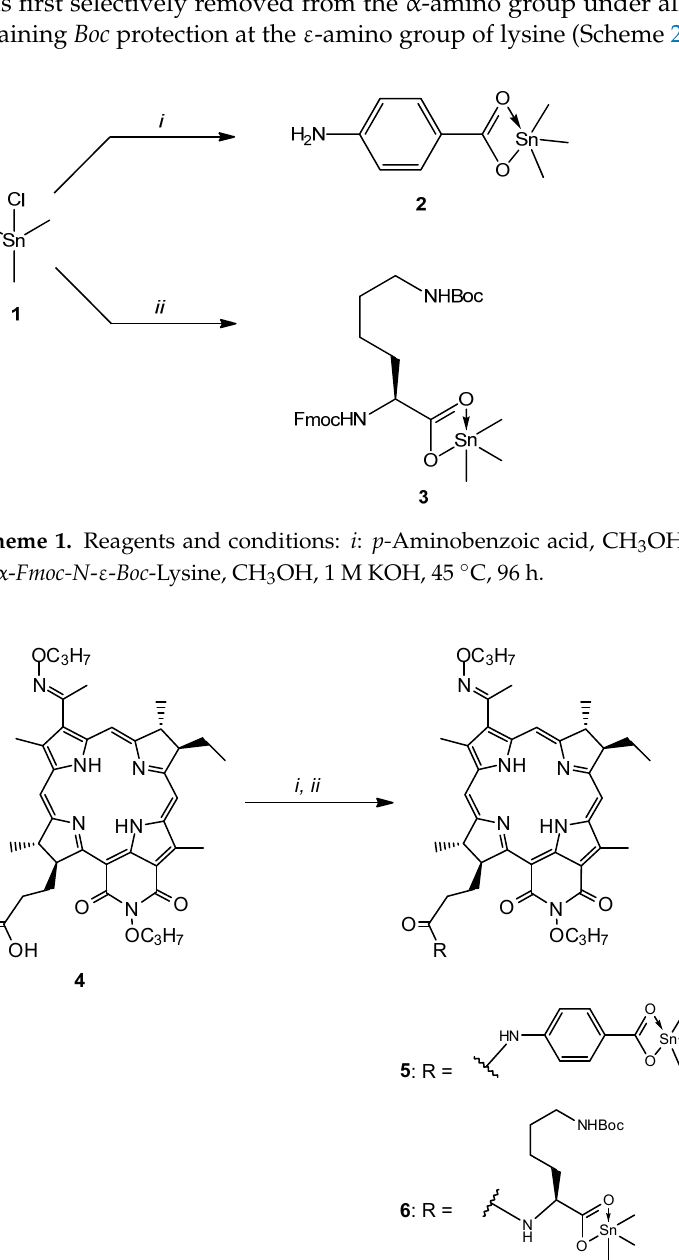
Figure 1. Electronic absorption ( a ) and fluorescence ( b ) spectra of the compounds obtained. 2.2. Docking Molecular docking is an important tool in drug development. It plays a significant role in understanding the mechanism of the interaction between the ligand being studied and the corresponding biological target that can be represented by a specific DNA se- quence or by specific protein binding sites. It should be noted that DNA is not a